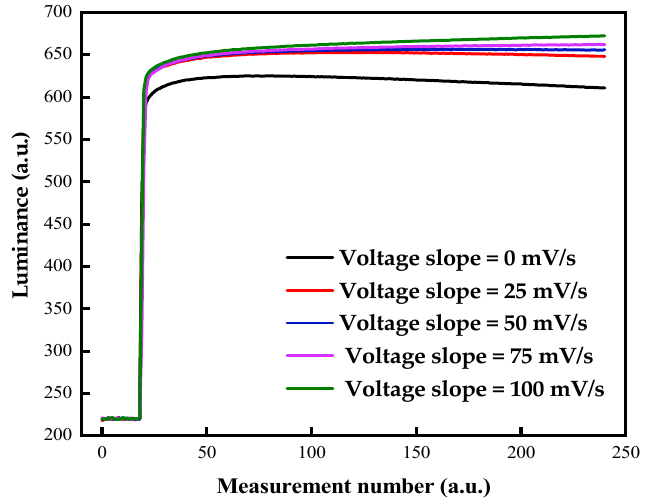
Figure 9. Luminance curves when the EWD was driven by voltages with different slopes in the oil stabilization stage. The luminance curve remained stable, and oil could be stabilized when the voltage slope was set to 50 mV/s.